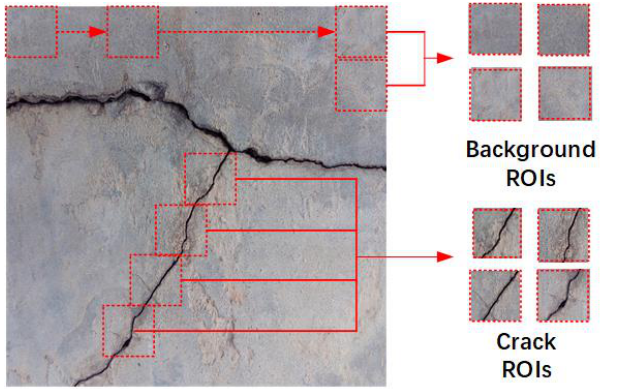
Figure 5. Diagram illustrating the method for preparing datasets for the CPD network, which consists of crack and background regions of interest (ROIs).